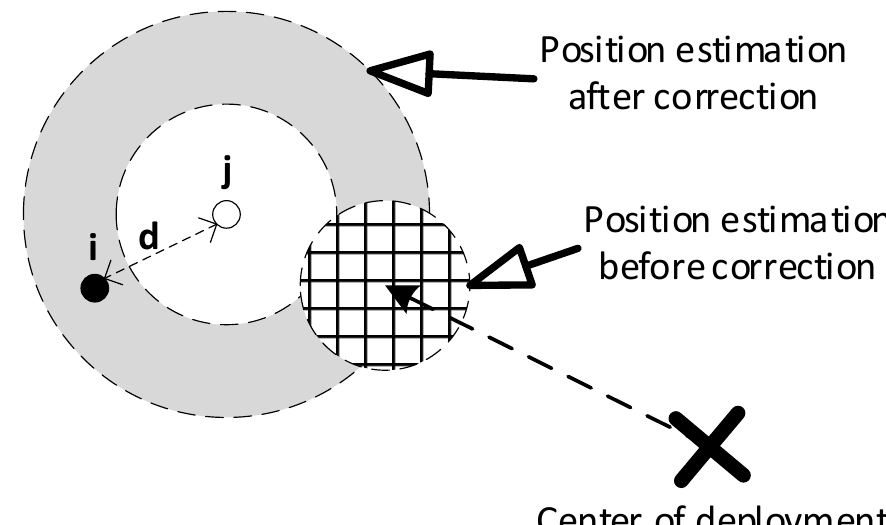
Figure 14. Example scenario when unknown node i gets initial broadcast message from neighbor node j , with a distance measurement of d . The black cross is the center of the whole deployment area. The grid circle region represents the position estimation using the original KickLoc algorithm. The grey ring-shaped region represents the position estimation after the